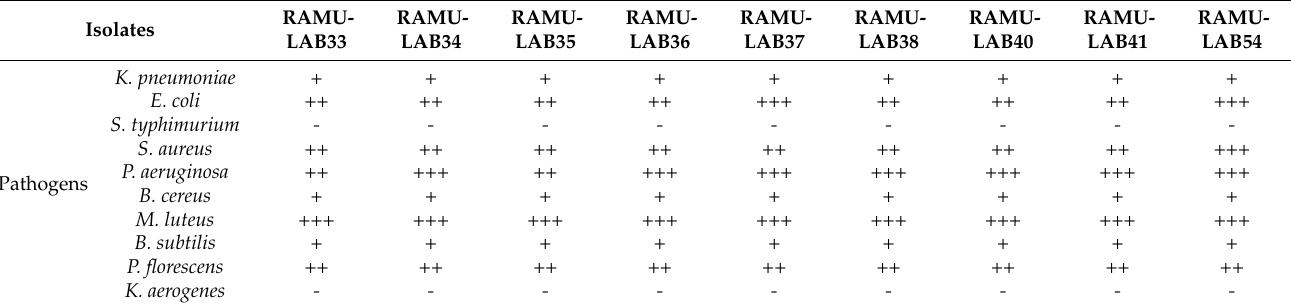
Table 6. Antibacterial activity of the fermented sugarcane